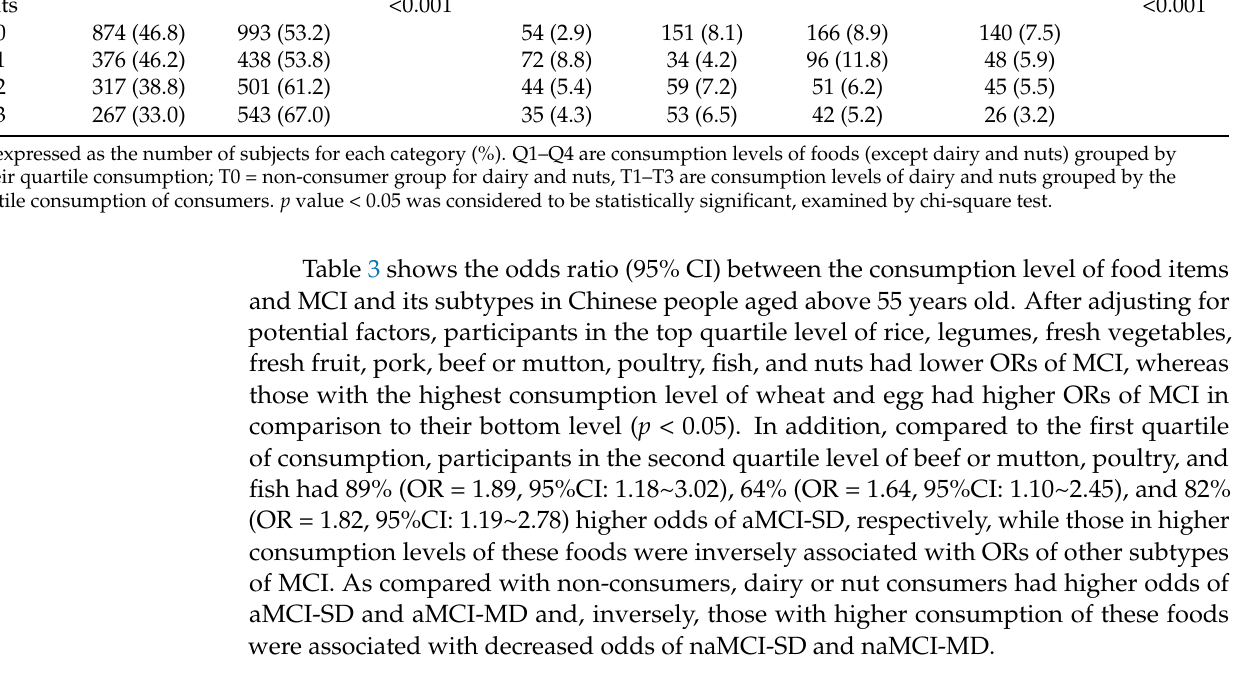
Table 3. Associations of food consumption with MCI and its subtypes using multiple logistic regression model a